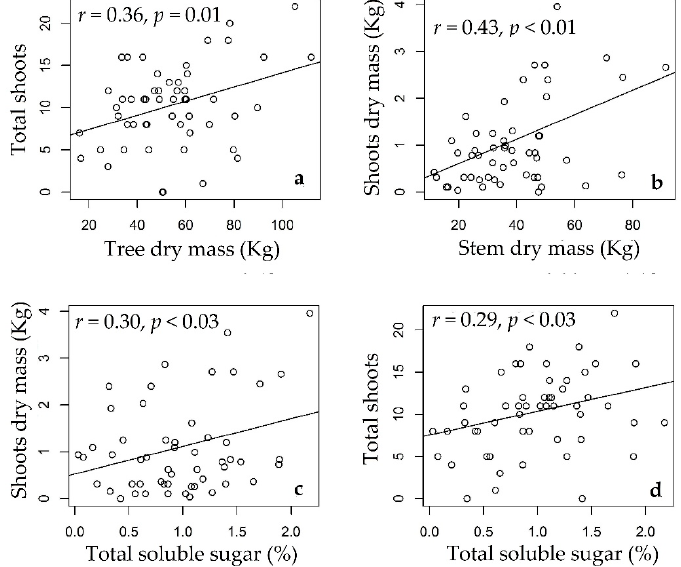
Figure A9. ( a ) Average increase in diameter; ( b ) height and; ( c ) sum of dry mass according to shoot management in 12-year-old rosewood plantations managed in the region of Maués, AM.